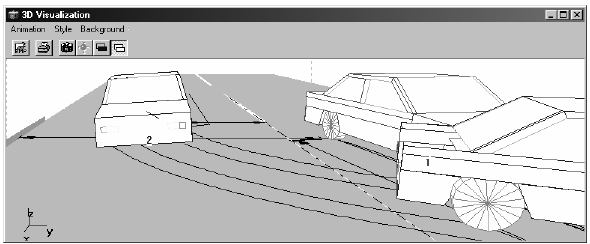
Fig 9. The space view of the course of the traffic